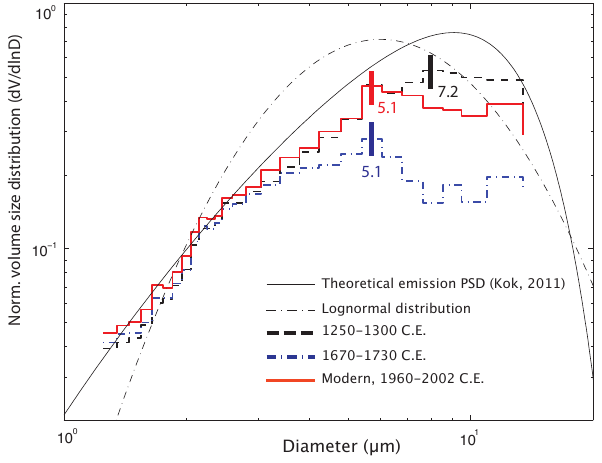
Figure 4. Normalized volume size distribution, d V /dln D , for three representative time periods along with theoretical dust emission par- ticle size distribution (PSD) formulated by Kok (2011b) and a rep- resentative lognormal distribution. Vertical colored bars indicate the mode (most commonly occurring value) of each observed distribu- tion. The lognormal distribution is parameterized as described by Delmonte et al. (2002), with mode diameter = 6µm and geometric standard deviation =